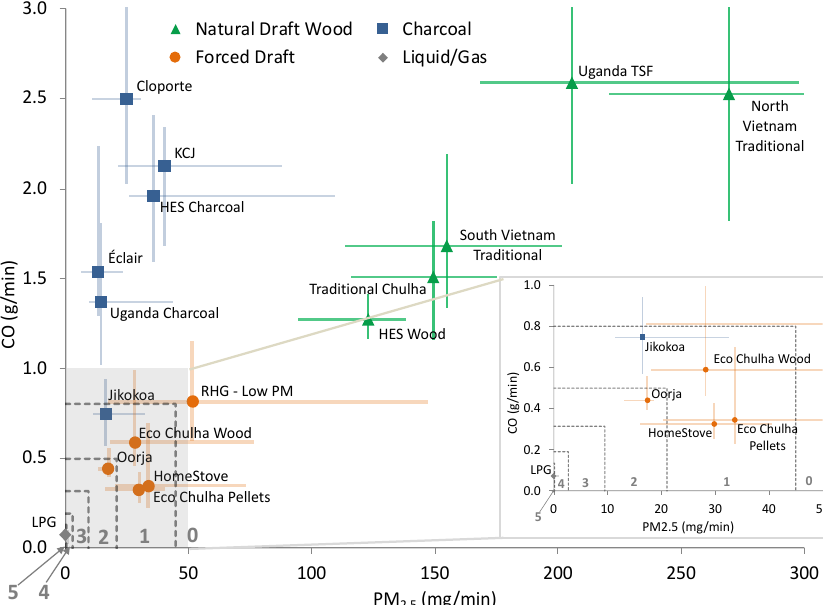
Figure 1. Median PM 2.5 and CO emission rates with the ISO Voluntary Performance Targets emissions tiers indicated by the dashed lines. Error bars represent interquartile ranges (IQRs). The region within the grey box is zoomed in for clarity in the bottom right hand corner. Notes: For clarity, the rice husk gasifier (RHG) high particulate matter (PM) is not included as its PM 2.5 emissions far exceeded the axis scale (PM 2.5 : 813 mg / min; CO: 0.89 g /